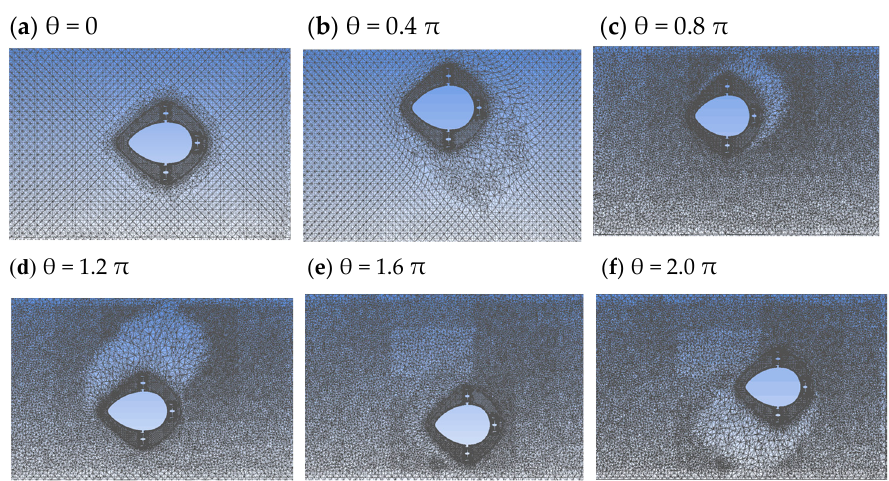
Figure 17. Underwater robot system circular motion mesh change under Va equals 2.0 kn. ( a ) θ = 0; ( b ) θ = 0.4 π ; ( c ) θ = 0.8 π ; ( d ) θ = 1.2 π ; ( e ) θ = 1.6 π ; ( f ) θ = 2.0 π .